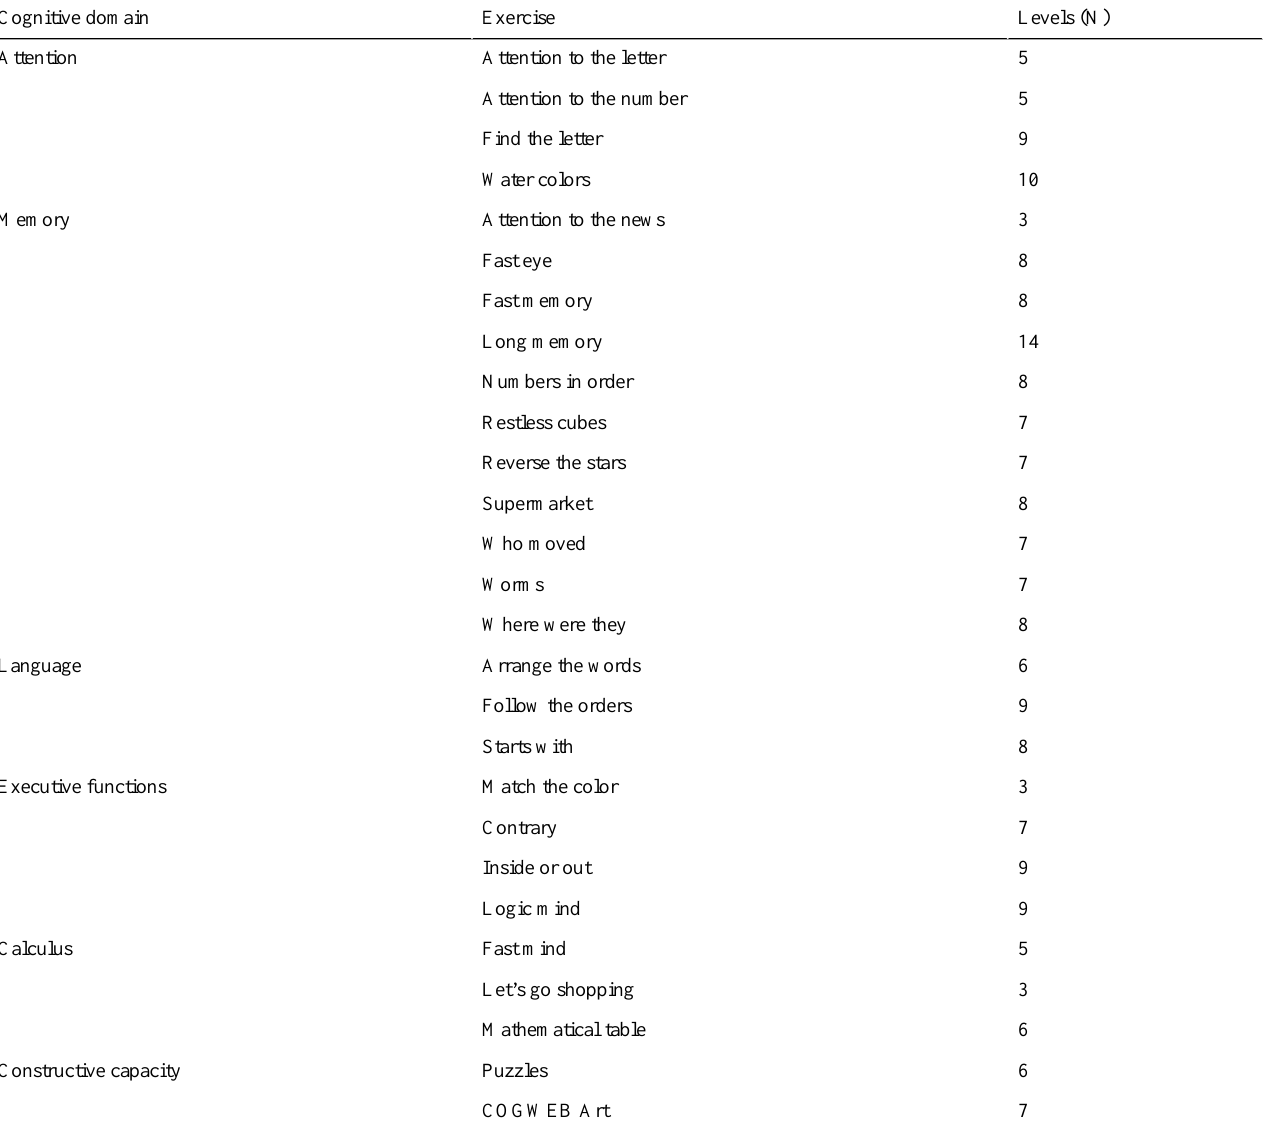
Table 4. Available exercises per cognitive